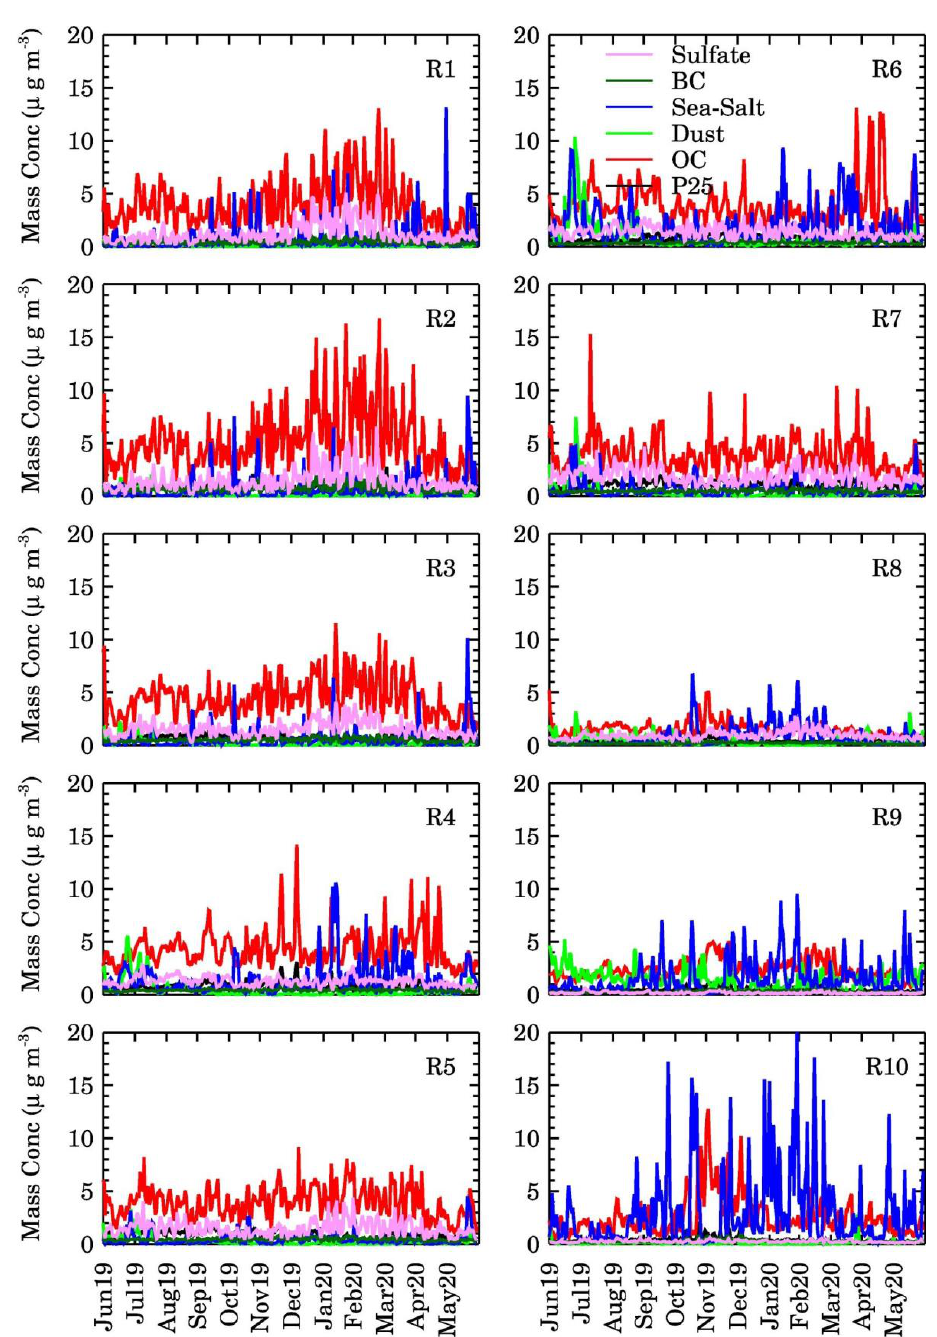
Figure 12. Variations in daily averaged WRF-Chem forecasted surface PM 2.5 chemical composition in 10 EPA regions from 1 June 2019 to 31 May 2020.